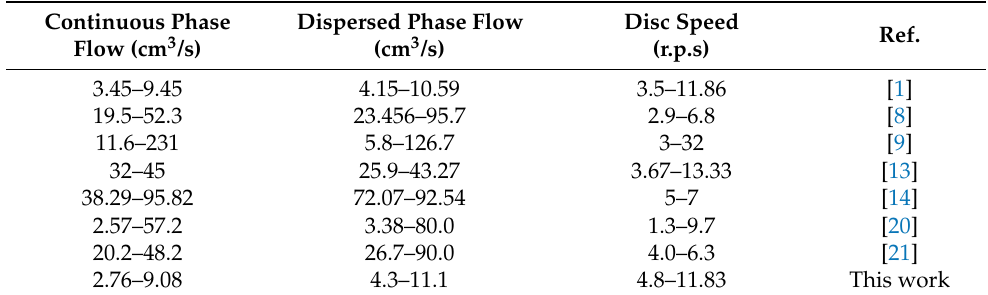
Table 2. Comparison between the operating conditions of the present study and various studies found in the